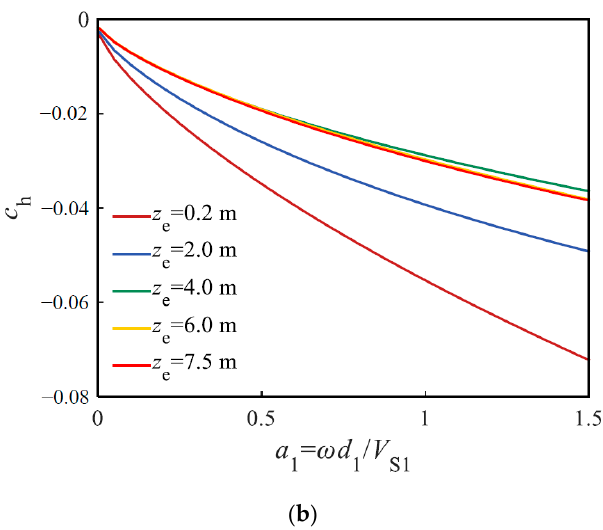
Figure 10. Influence of weak pile segment position on the HDI of pile head. ( a ) Stiffness factor of HDI and ( b ) damping factor of HDI.